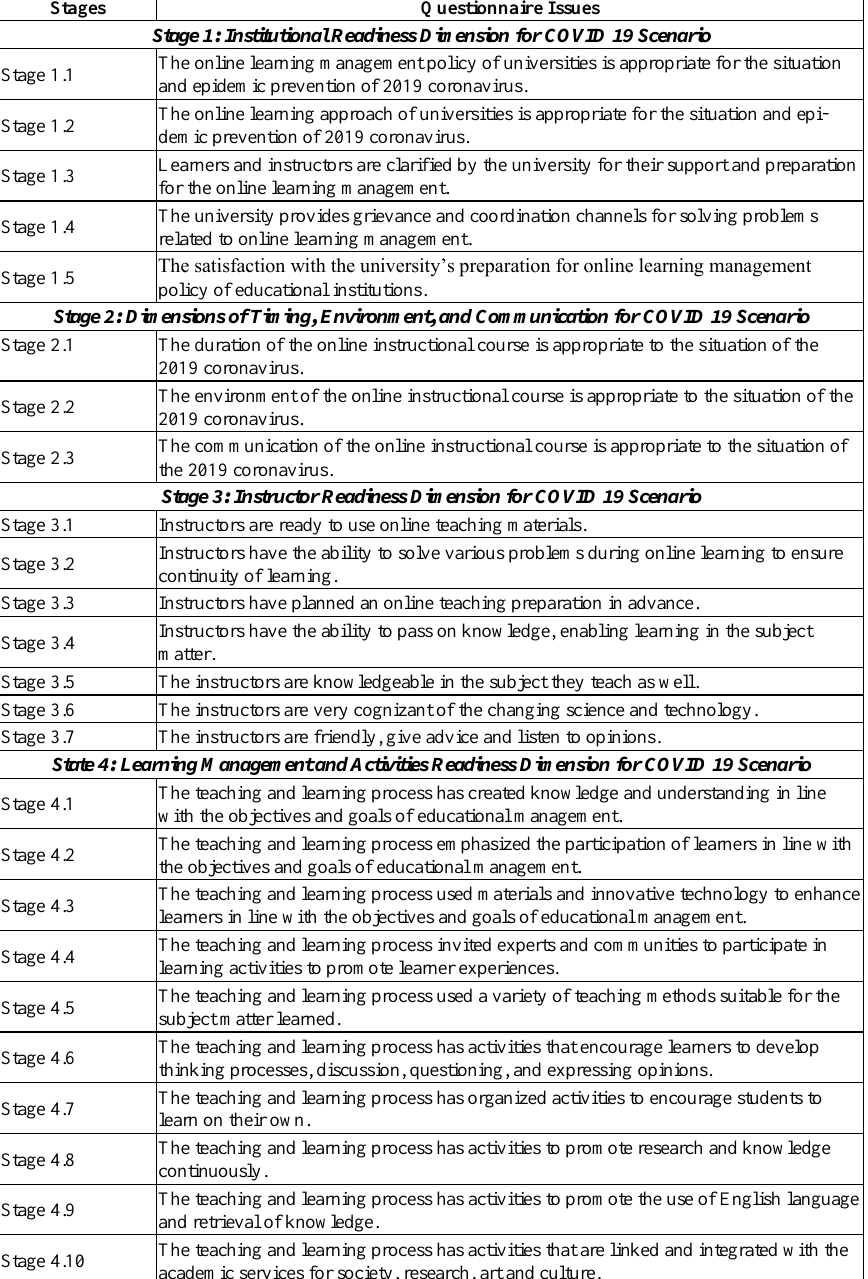
Table 1. Questionnaire issues with online learning management on the impact of COVID-19